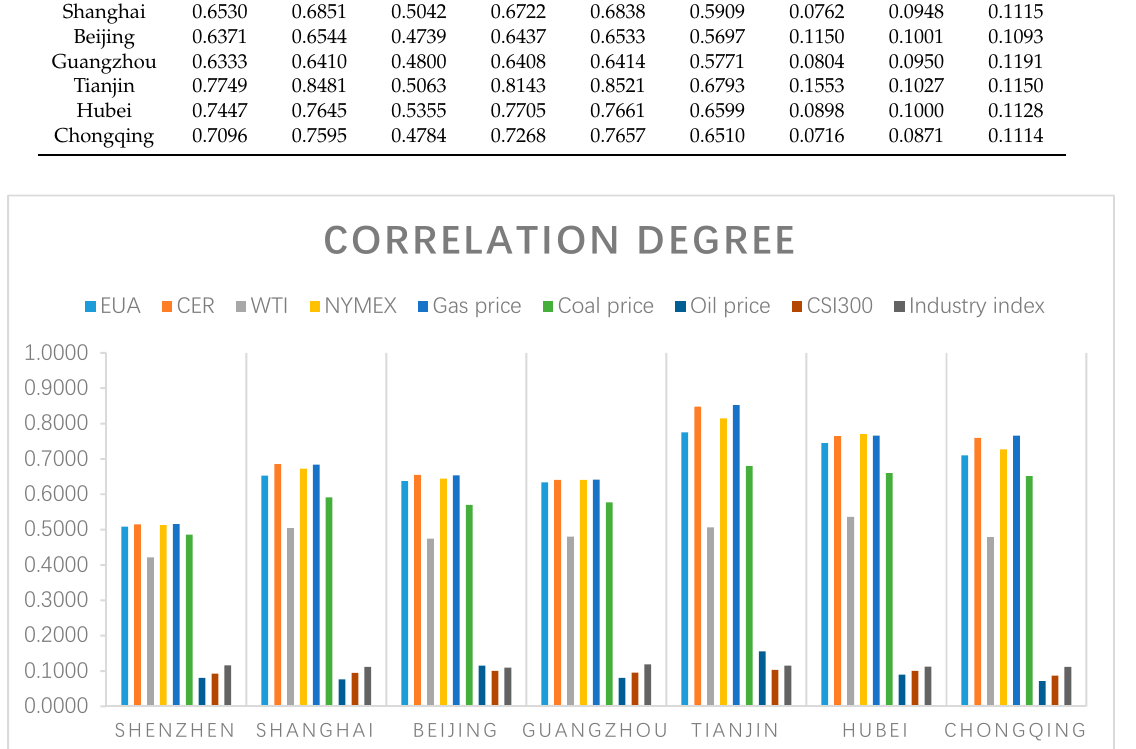
Figure 7. Correlation degree of the influence factors.